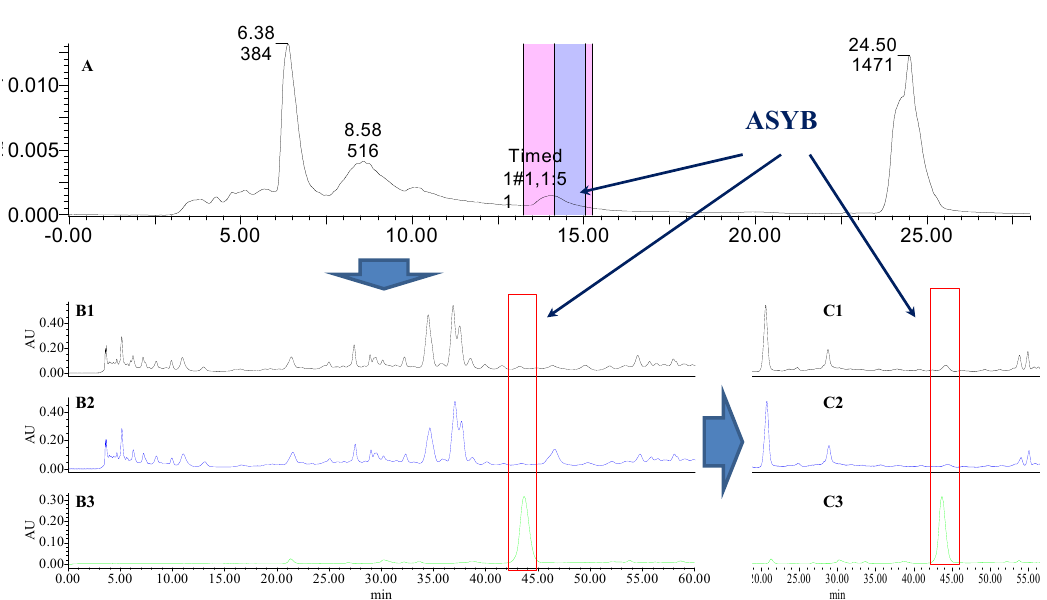
Figure 17. The preparative and analytical chromatograms of the depletion of ASYB from CF-GL. ( A ) preparative chromatogram at 270 nm; ( B1 ) analytical chromatogram of CF-GL at 270 nm; ( B2 ) analytical chromatogram of CF-GL-B at 270 nm; ( B3 ) analytical chromatogram of ASYB depleted from CF-GL at 270 nm. ( C1 ) analytical chromatogram of CF-GL at 400 nm; ( C2 ) analytical chromatogram of CF-GL-B at 400 nm; ( C3 ) analytical chromatogram of ASYB depleted from CF-GL at 400 nm.